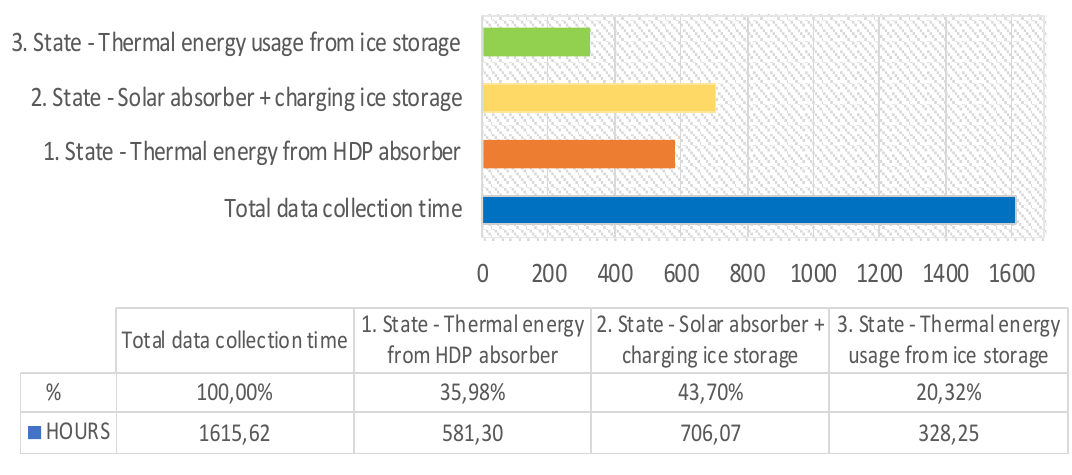
Figure 11. Heat pump processes overview.